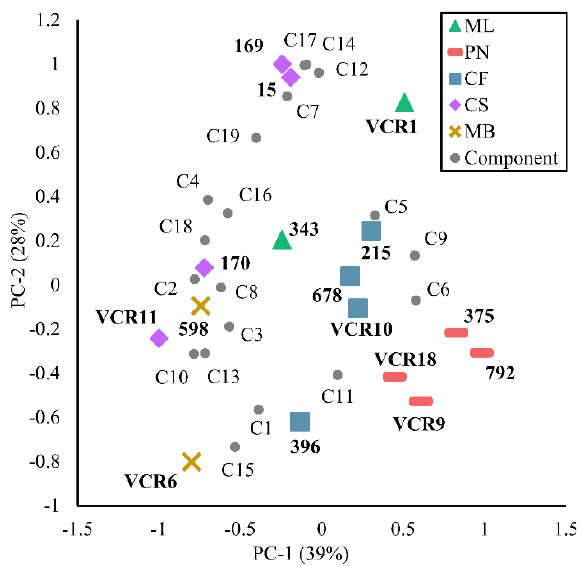
Figure 2. Loadings of fermented and varietal aroma compounds and the distribution of the wine samples in the first two PCs. C1: ethyl acetate; C2: isobutyl acetate; C3: ethyl butyrate; C4: isoamyl acetate; C5: isobutanol; C6: 1-butanol; C7: isoamyl alcohol; C8: ethyl caproate; C9: ethyl lactate; C10: ethyl octanoate; C11: decanal; C12: isobutyric acid; C13: ethyl decanoate; C14: isovaleric acid; C15: ethyl 9-decenoate; C16: hexyl alcohol; C17: 2-phenylethanol; C18: octanoic acid; C19: decanoic acid.